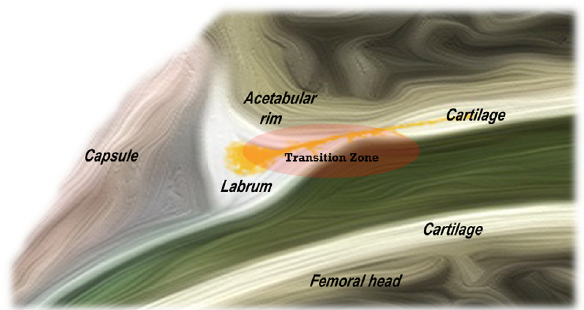
Figure 1. Diagram showing the transition zone of chondrolabral